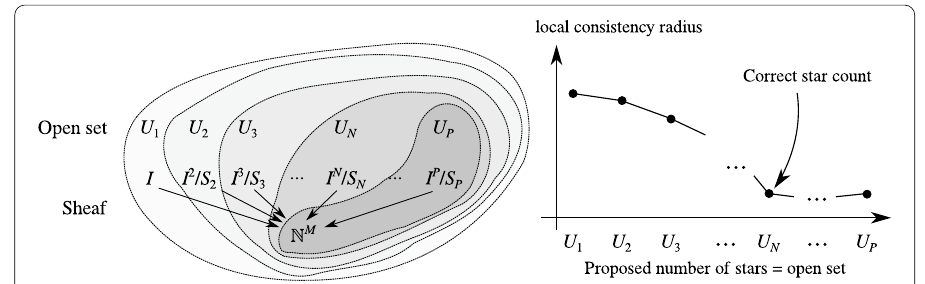
Fig. 2 Determining the correct number of stars by iterating over open sets in the